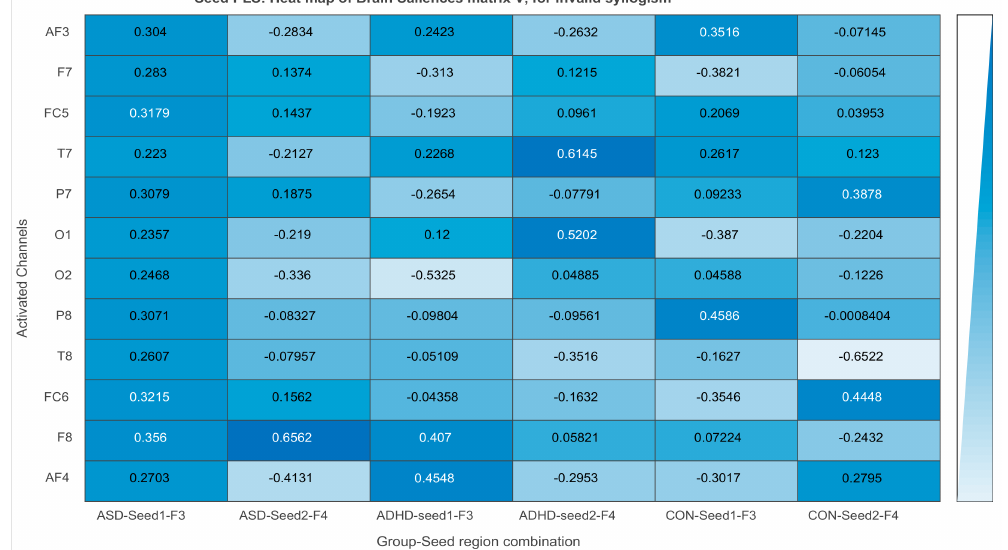
Figure 23. Heat map of the brain salience matrix V extracted by SVD of correlation matrix R between brain X and seed Y matrices, for the invalid